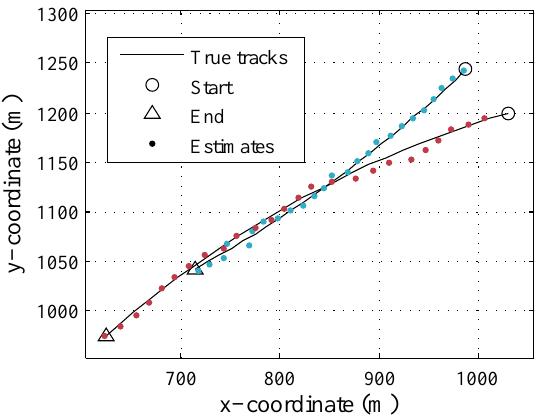
Figure 4. The true trajectory and estimated trajectory after applying the proposed